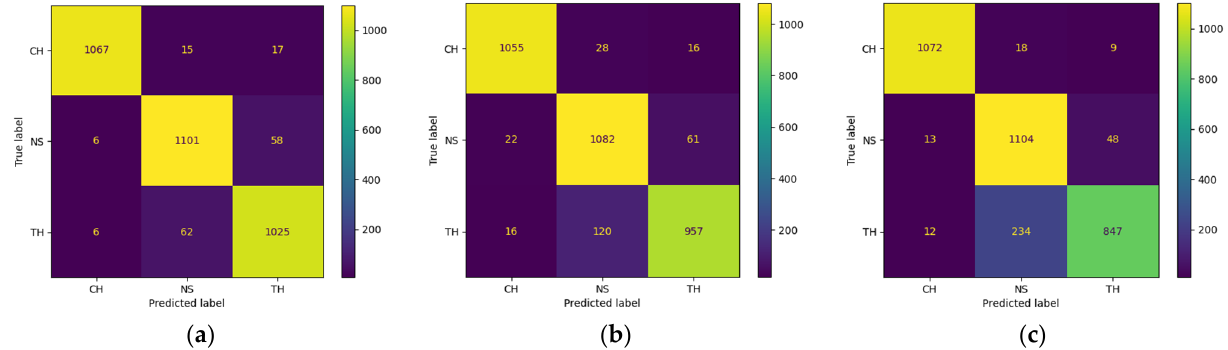
Figure 4. Confusion matrices for THD-RawNet, SoundNet (8 Conv layers), and AlexNet. CH, NS, and TH denote the car horn, noise, and train horn classes, respectively. ( a ) THD-RawNet. ( b ) Sound- Net (8 Conv layers). ( c )